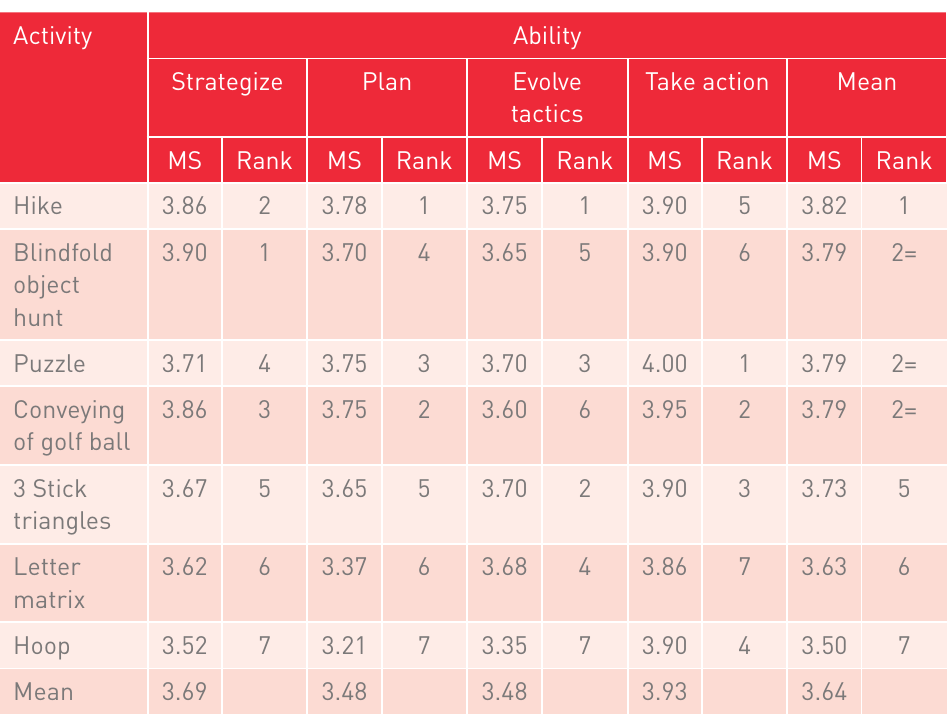
Summary of the extent to which all the activities enhanced the four abilities of